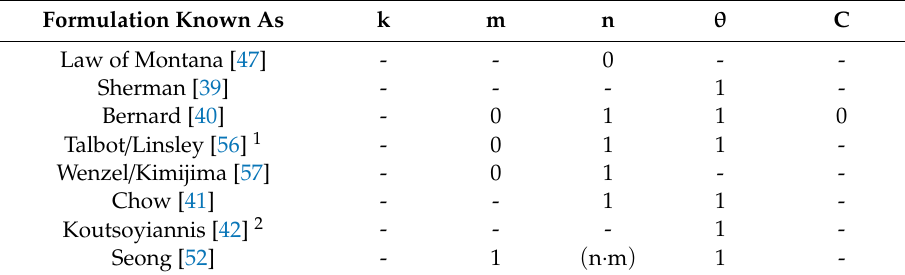
Table 1. Values of the coe ffi cients of Equation (2) according to di ff erent authors. Formulation Known As k m n θ C Law of Montana [47] - 0 - - - Wenzel / Kimijima [57] - 0 - - - 1